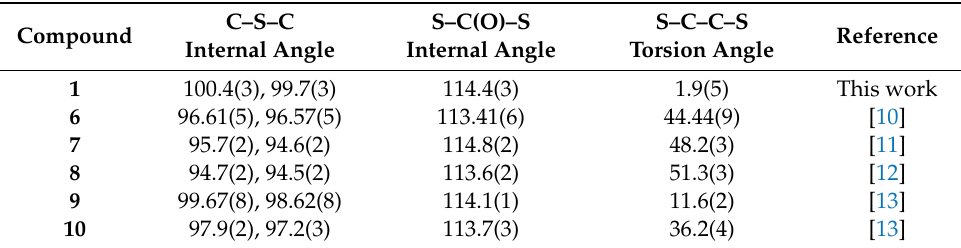
Figure 3. A survey of crystallographically characterised 1,3-dithiolan-2-ones with Cambridge Structural Database (CSD) reference codes. Table 2. Key angles in the structures of dithiolanones (°).